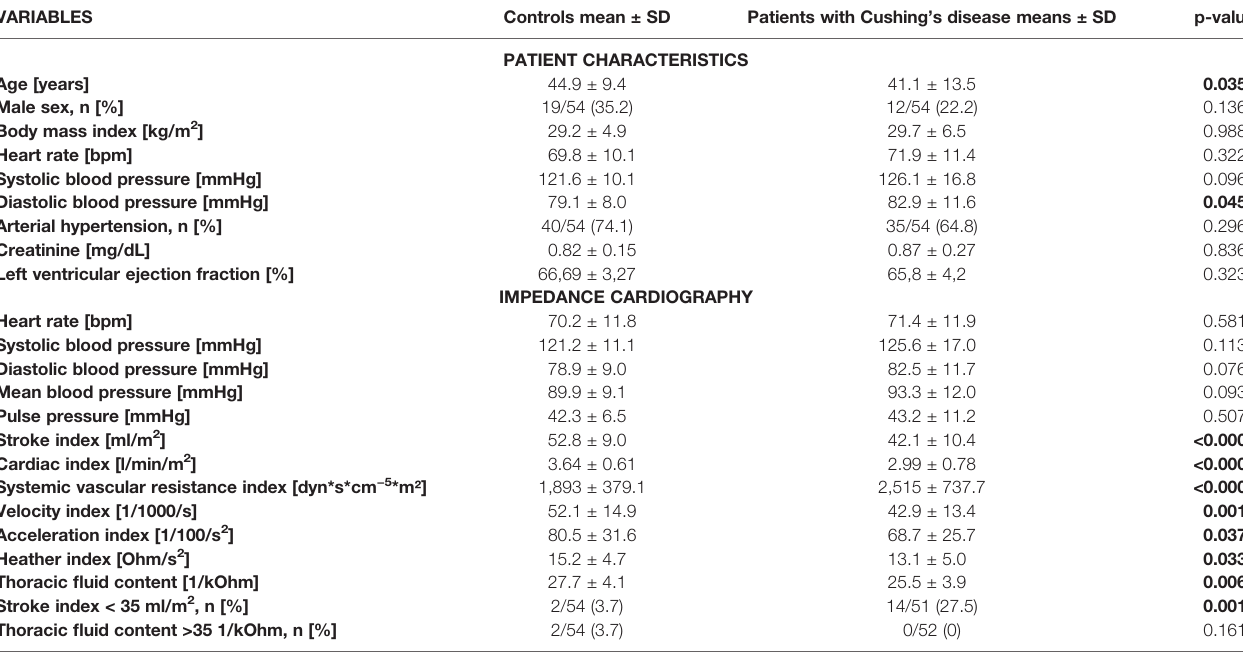
TABLE 1 | Comparison of the control group and Cushing ’ s disease group in terms of patient characteristics and the hemodynamic parameters assessed with impedance cardiography.